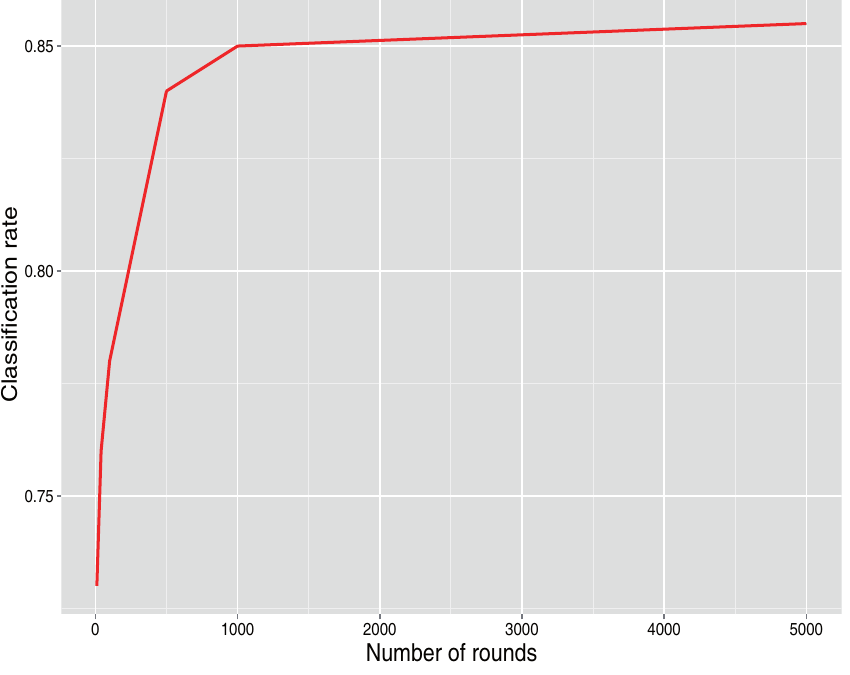
Figure 6. Classification rate vs. the number of rounds